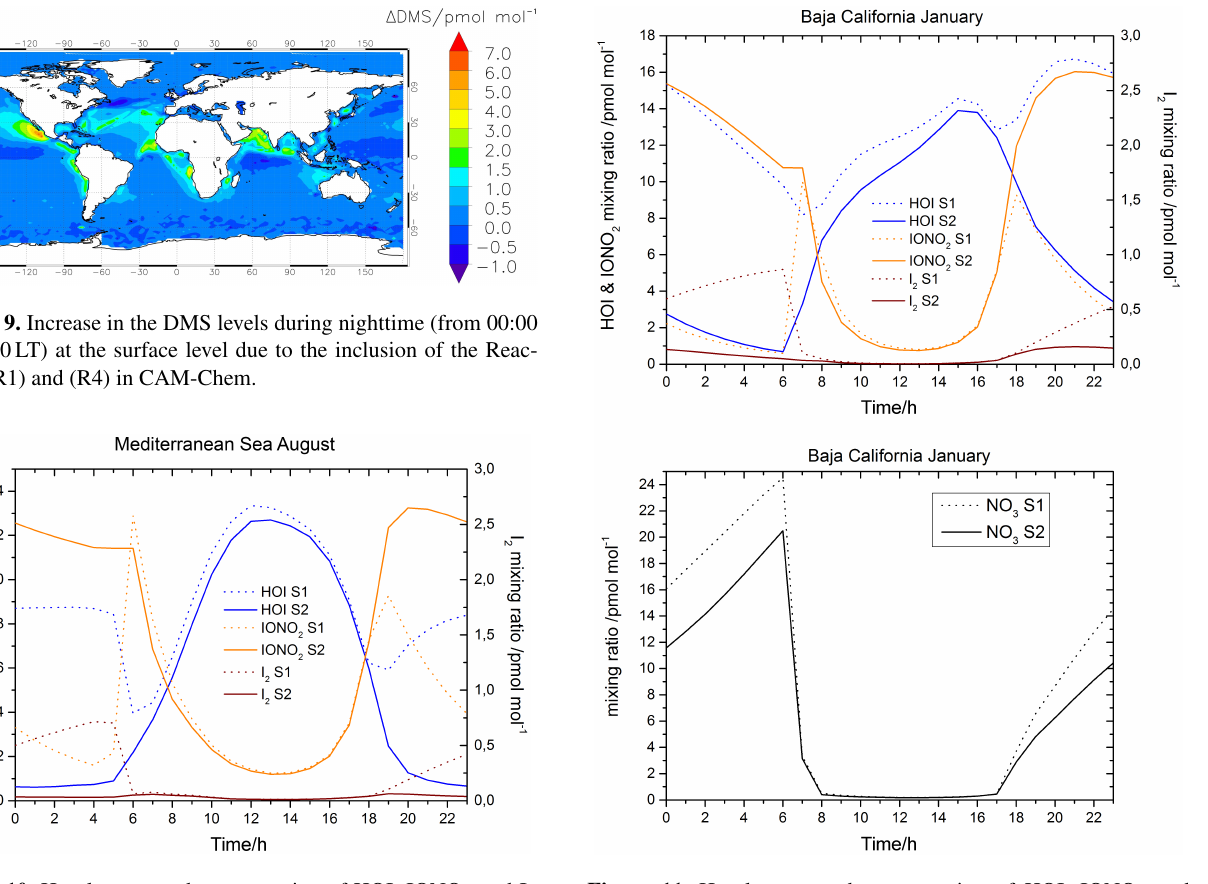
Figure 11. Hourly averaged concentration of HOI, IONO 2 and I 2 (upper panel) and NO 3 (bottom panel) in the Pacific Ocean at the south of Baja California Peninsula at the surface level (long: − 110 →− 106 ◦ E, lat: 16 → 23 ◦